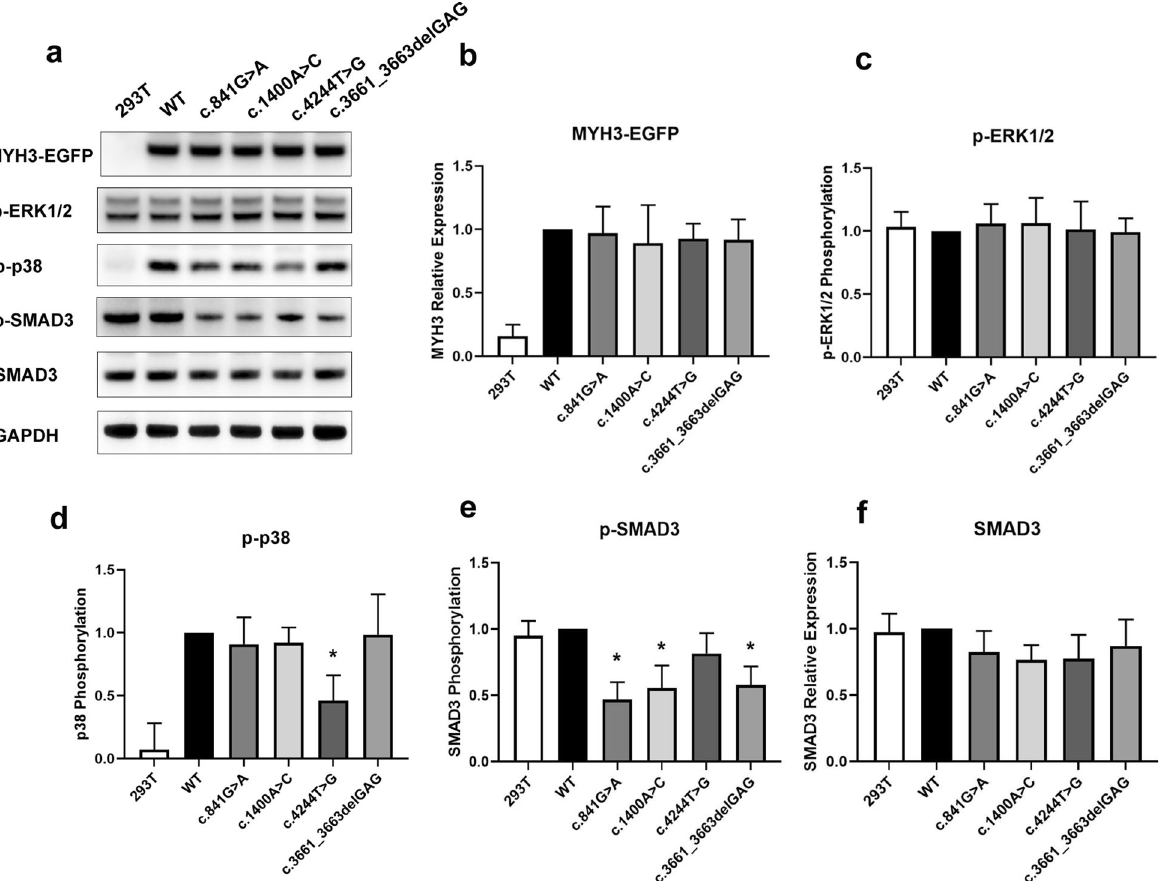
Fig. 4 Expression of MYH3 and proteins in TGF- β /BMP signaling pathway (SMAD3 and phosphorylated SMAD3) in cells transfected with wild-type (WT) and mutant MYH3 plasmid. a Western blot results of MYH3 expression and proteins in TGF- β /BMP signaling pathway in HEK 293T cells transfected with empty plasmid, WT and mutant MYH3 plasmid. b Quanti fi cation of the MYH3 protein. c – f Quanti fi cation of TGF- β / BMP signaling pathways alterations on protein expression levels pERK1/2, p-p38, p-SMAD3, and SMAD3. c.841G>A, c.1400A>C and c.3661_3663delGAG variants lead to decreased stimulatory effect of MYH3 on SMAD3 phosphorylation, whereas c.4244T>G leads to decreased p-p38 expression. Western blot data was analyzed as ratios against samples transfected with the WT plasmid. The WT plasmid samples were set at a value of 1. The results are shown as the mean ± standard error of three independent